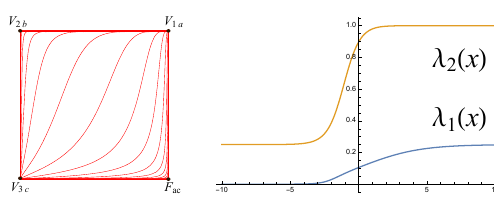
((cid:22) x; (cid:13) ) (left) and (cid:12)eld components 2